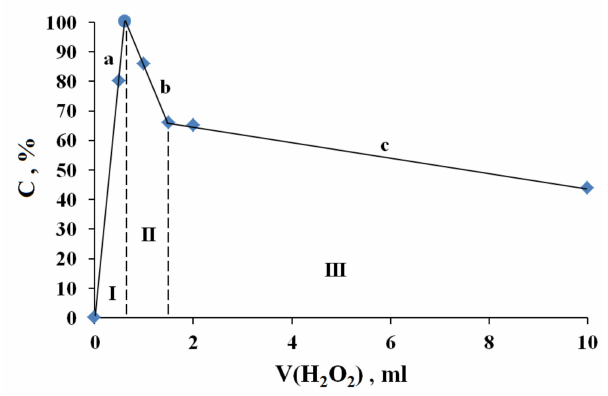
Figure 8. The dependence of C on V(H 2 O 2 ), fast introduction. Presumably, the presence of a maximum C at V(H 2 O 2 ) = 0.625 mL is associated